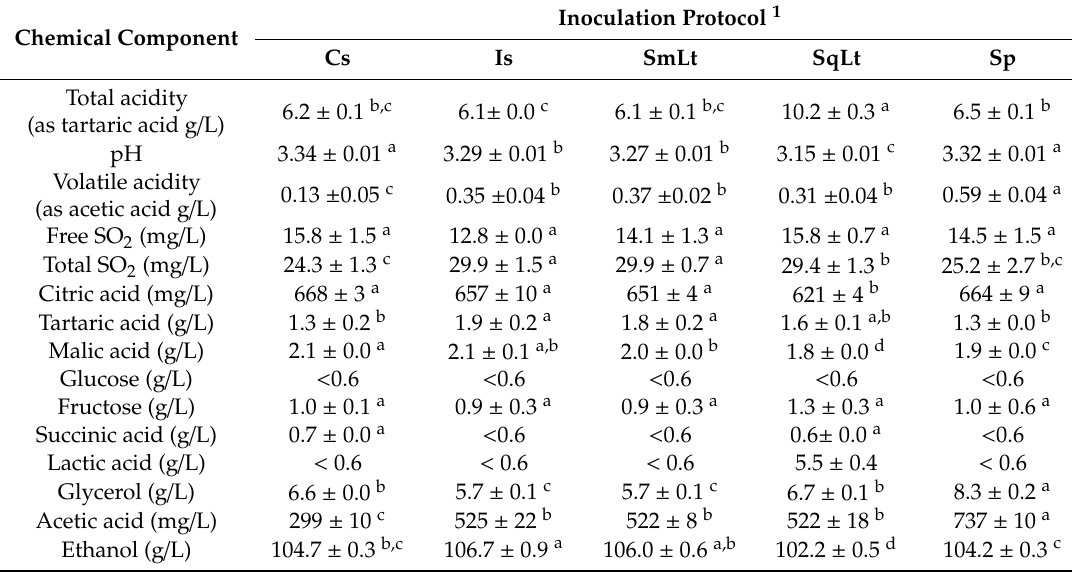
Table 4. Chemical characteristics of wines produced from natural grape must (mean ± SD, n = 3). Values with di ff erent superscript letters within each row di ff er significantly ( p < 0.05).